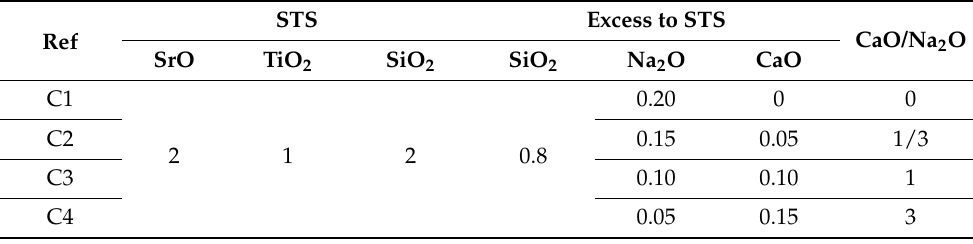
Table 1. Compositions of the parent